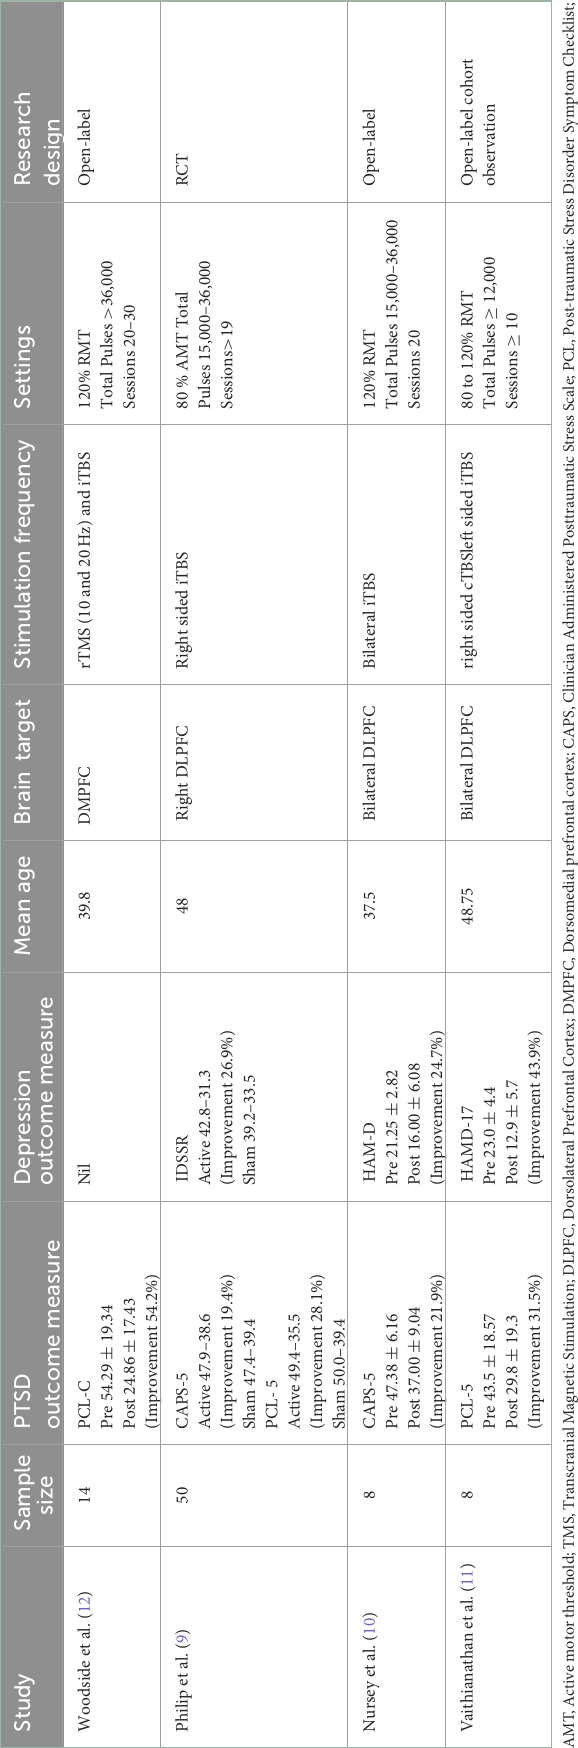
TABLE 1 Clinical outcomes during the TBS